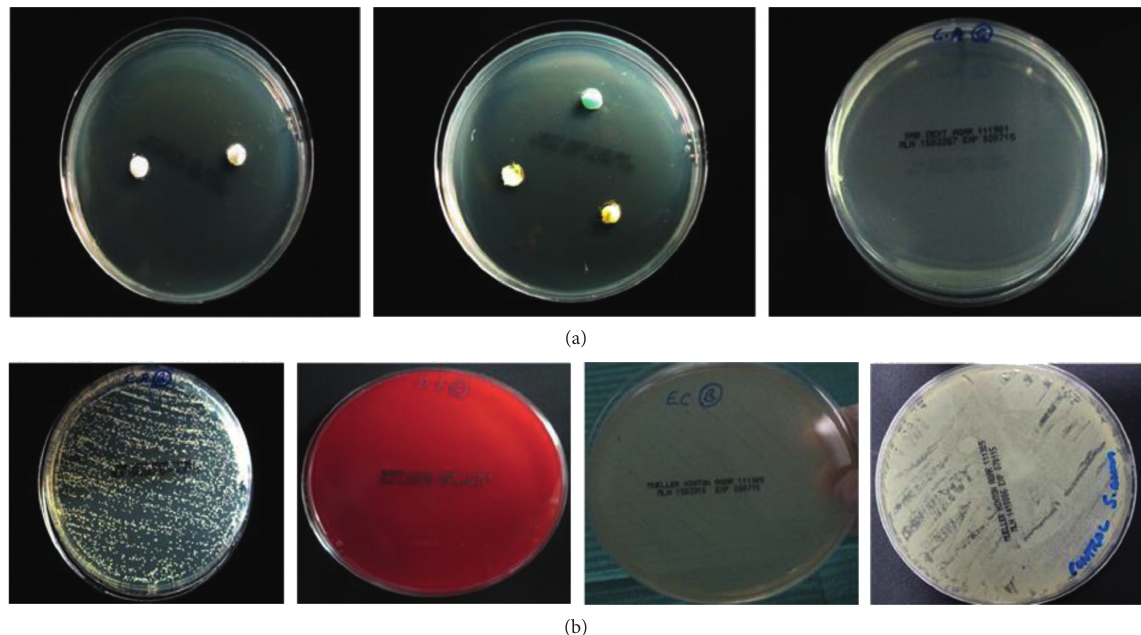
Figure 2: Agar plates for growth controls: (a) Negative growth controls; (b) Positive growth